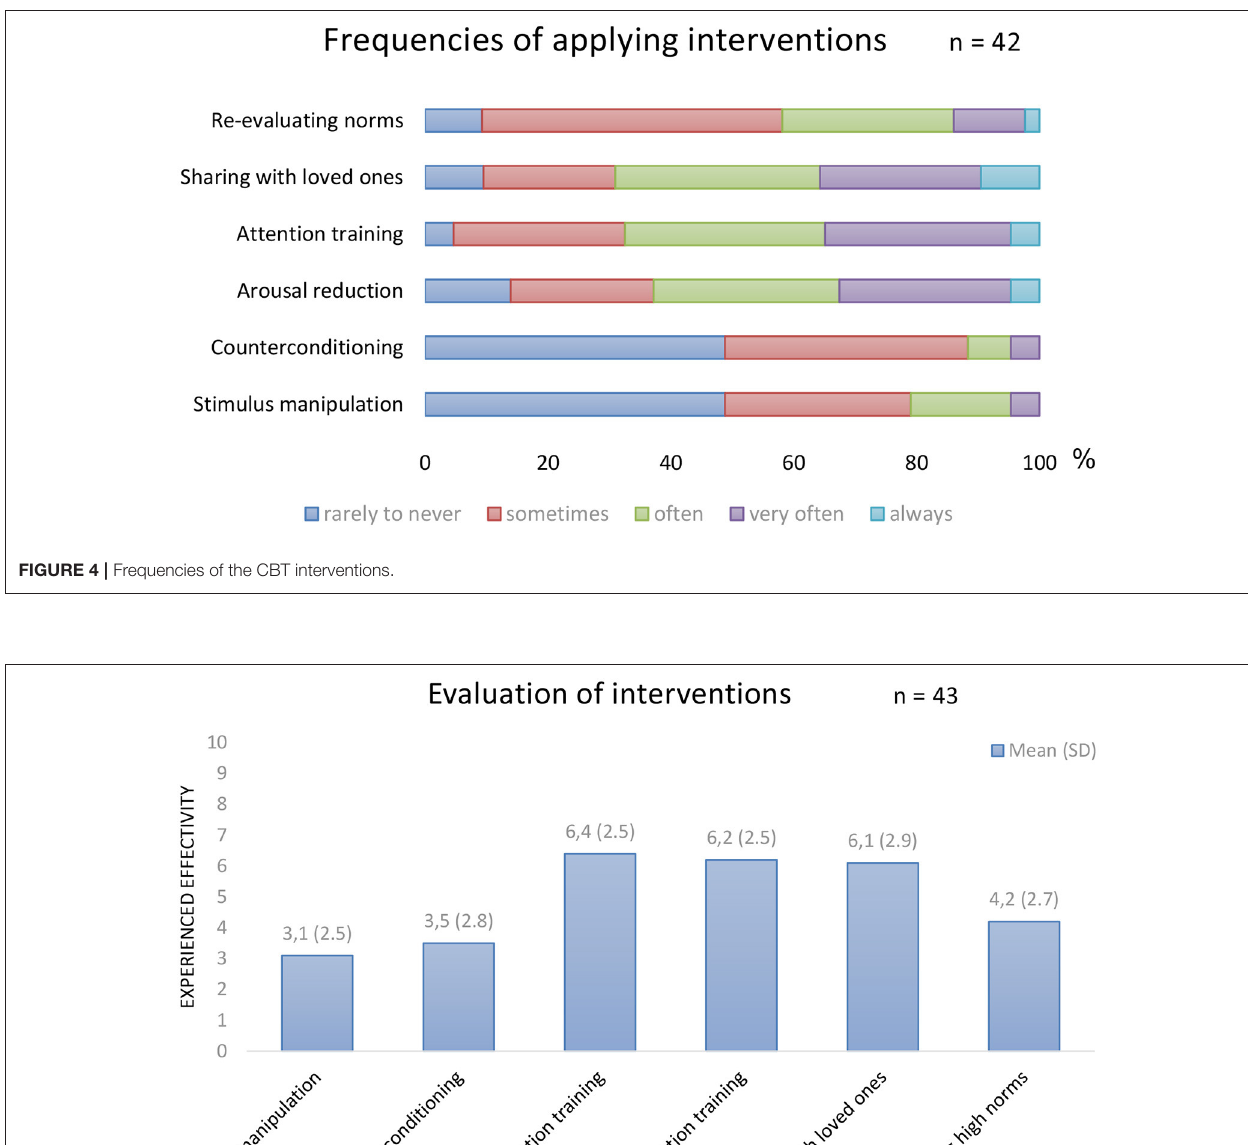
example saying “Just breathe!,” when she got annoyed) and the tension at home decreased. She lost the hyper focus on most trigger sounds. The eating sounds of her mother remained a trigger for Charlotte, but she no longer avoided eating with her parents. She was able to cope in a functional manner when an emotional reaction was provoked. Charlotte stated she felt more relaxed and free in social interactions with other people.